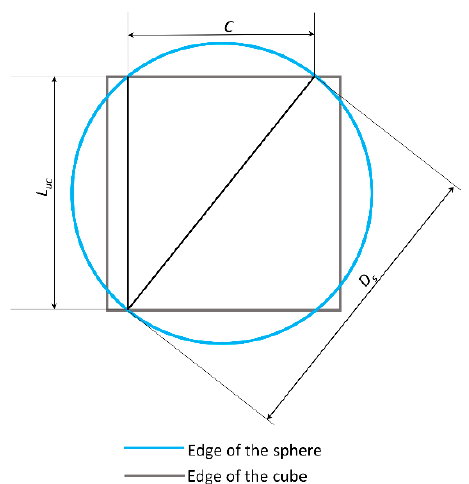
Table 1. Constraint equations that the diameter of the sphere D s and the cylinders D c must satisfy to guarantee the coherence of the scaffold geometry.